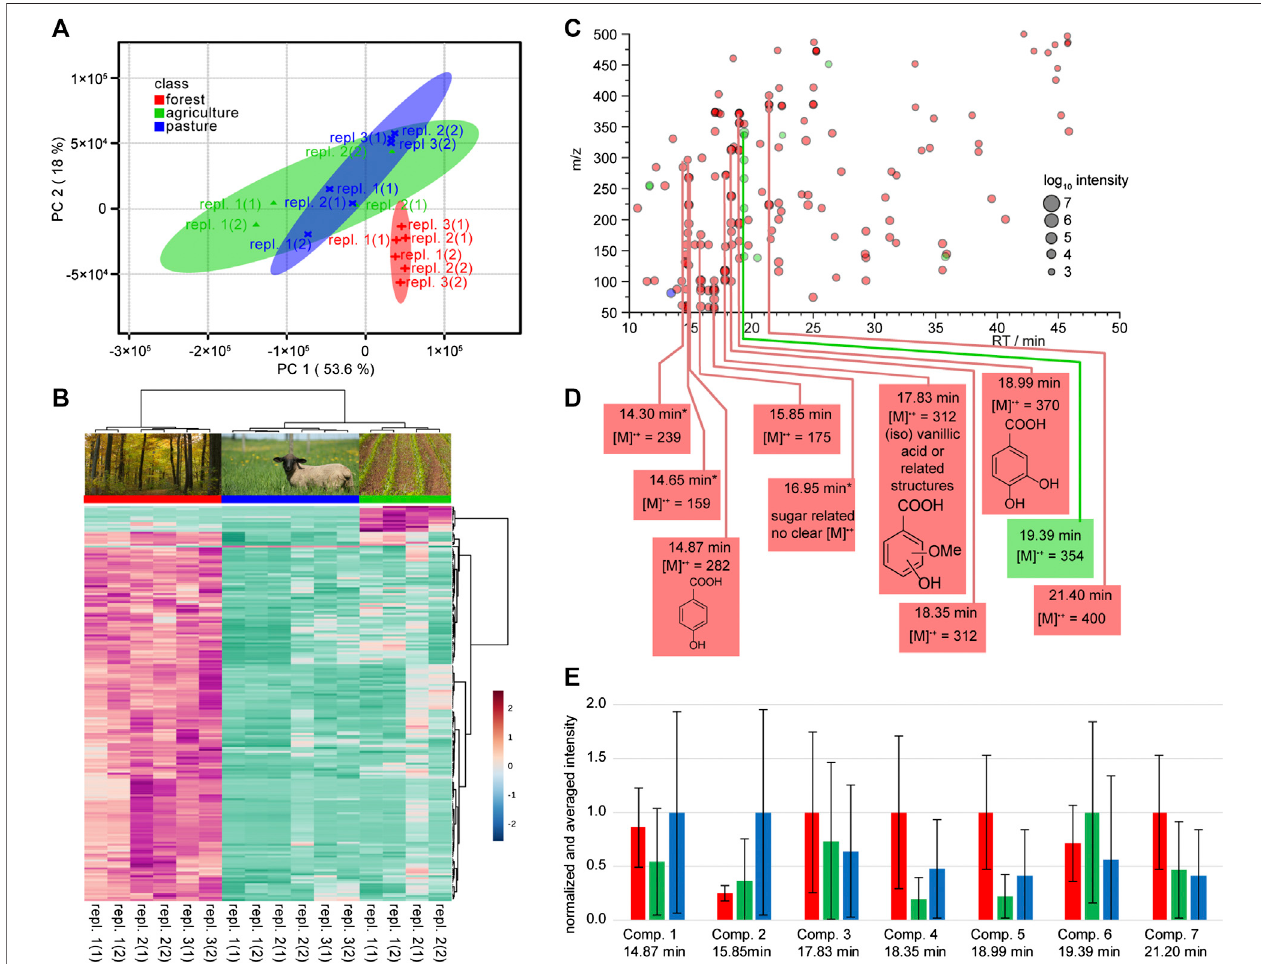
FIGURE 6 | Statistical analysis and structure elucidation of compounds from seepage water collected with lysimeters of type I. Lysimeters were installed at three different land use sites and data are assigned by red labels for the forest sites, green for the agricultural sites and blue for the pasture sites. (A) Principal component analysis (PCA) score plot of six replicates (environmental replicates are numbered, and technical replicates thereof are numbered in brackets) each for the different land use sites based on GC-MSdata. (B) Heat map ofthe top 200 (ANOVA) featuresthat contribute tothe differentland use sites. The dendrograms on top and side of theheatmapindicatesimilarityclustersofthesamplingsitesandmetabolites,respectively. (C) Cloudplotofthetop200featuresfromtheheatmapinFigurepart B .The color indicates therespectivehighest intensityfrom the sampling sites (by land use) and the cloud-size thesignal intensity inthe mass spectrum. Features that appear at the same retention time are labeled with vertical lines. The most probable chemical identity of these marked feature classes is summarized in part (D) . (E) Relative intensities of compounds from Figure part D . The graph shows averages (+/- standard deviation) across all replicates (environmental and technical) per respective land usesite,withthehighestvaluepereachcompoundnormalizedtoone.Thecompoundslabeledwith*inFigurepart D wereexcludedfromtheanalysisduetooverlapping signals.